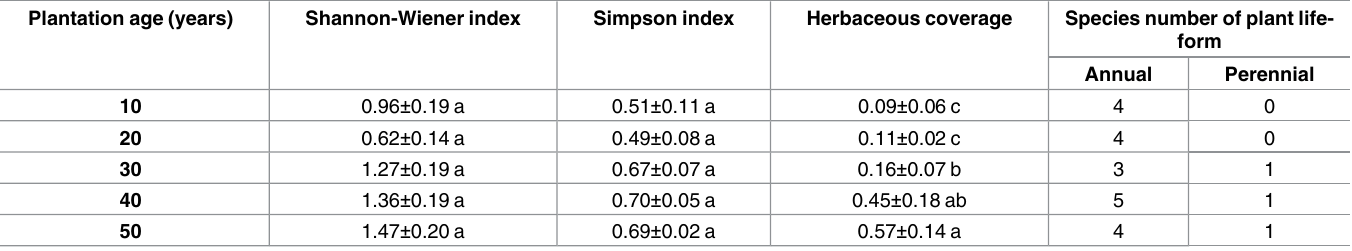
Table 2. Herbaceous species diversity indices, coverage and species number (mean ± SE) of life-form in H . ammodendron plantations established each decade over 50 years. Plantation age (years)